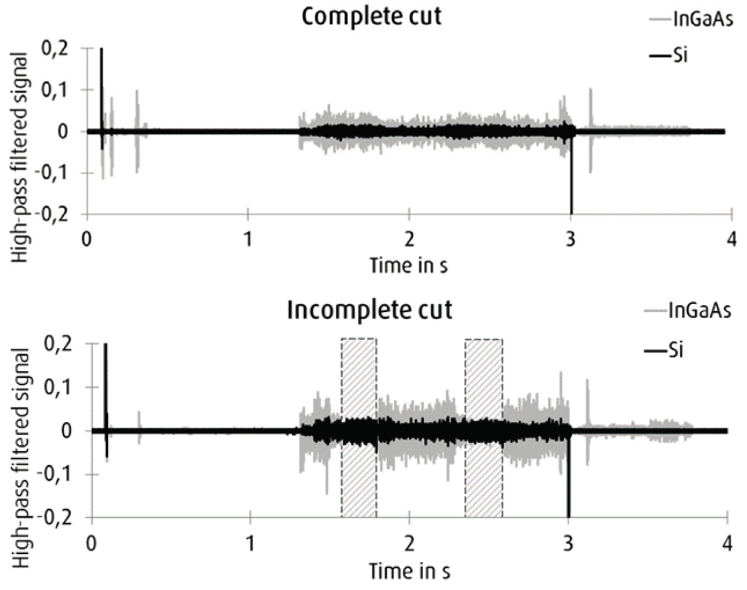
Figure 5. High pass filtered signal of a complete ( top ) and incomplete cut ( bottom ). The time domain in which the cutting interruption occurs is marked by the two grey shaded rectangular with dashed